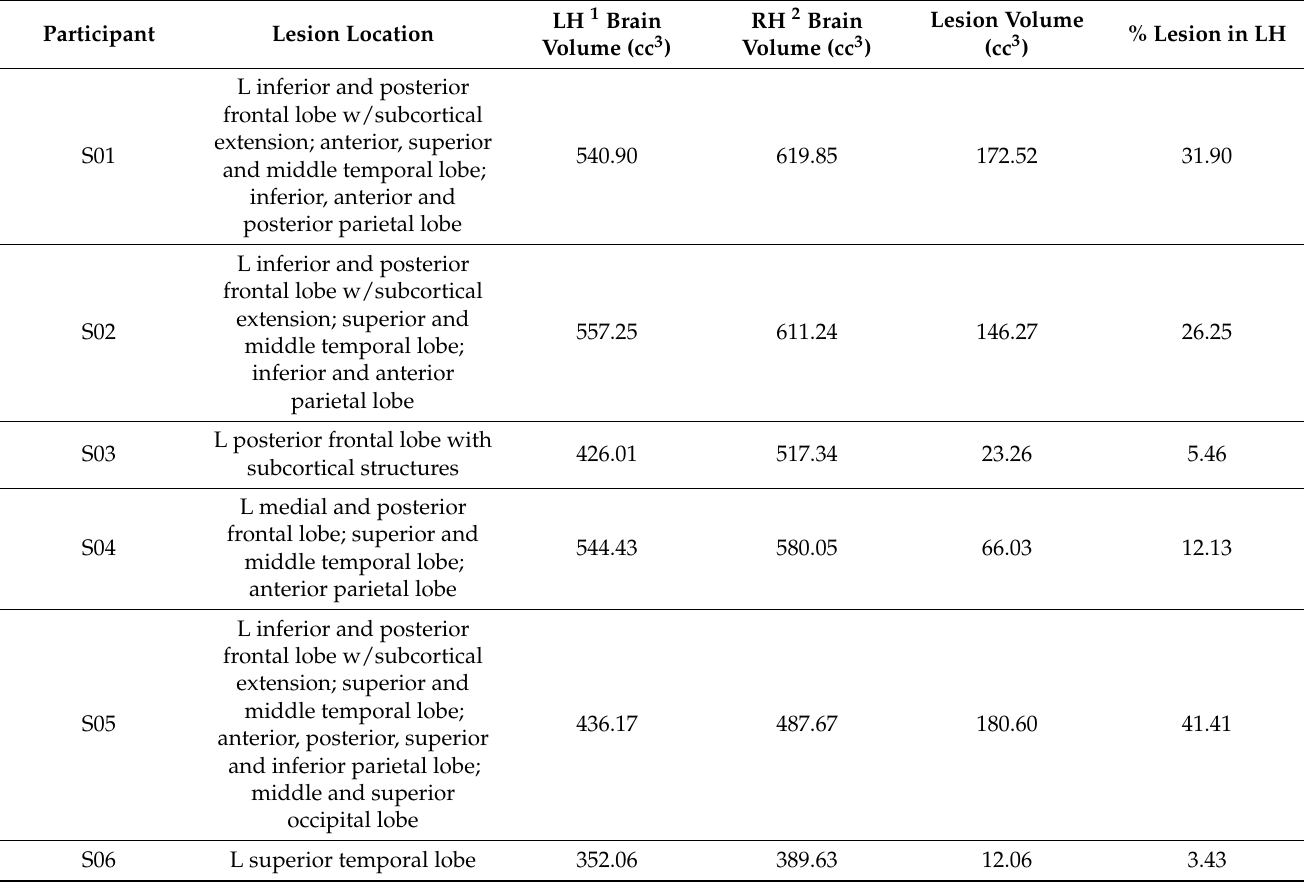
Table 2. A summary of lesion information and brain volume for each